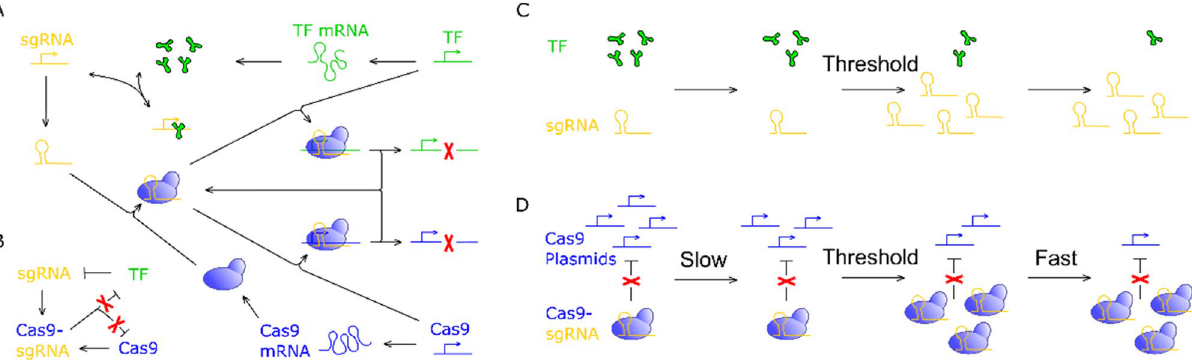
Figure 1. Time-delayed Cas9 elimination system. TF stands for transcription factor. ( A ) Detailed molecular mechanism of time-delayed Cas9 elimination system. ( B ) Kinetic schemes for time-delayed Cas9 elimination system. ( C ) Ultrasensitive relationship between transcription factor and sgRNA transcription. sgRNA transcription rate changes dramatically around a threshold concentration of transcription factor. ( D ) Ultrasensitive relationship between Cas9 plasmid (substrate) and Cas9-sgRNA (enzyme) is developed by circuit connection, which yields time-delayed Cas9 elimination.